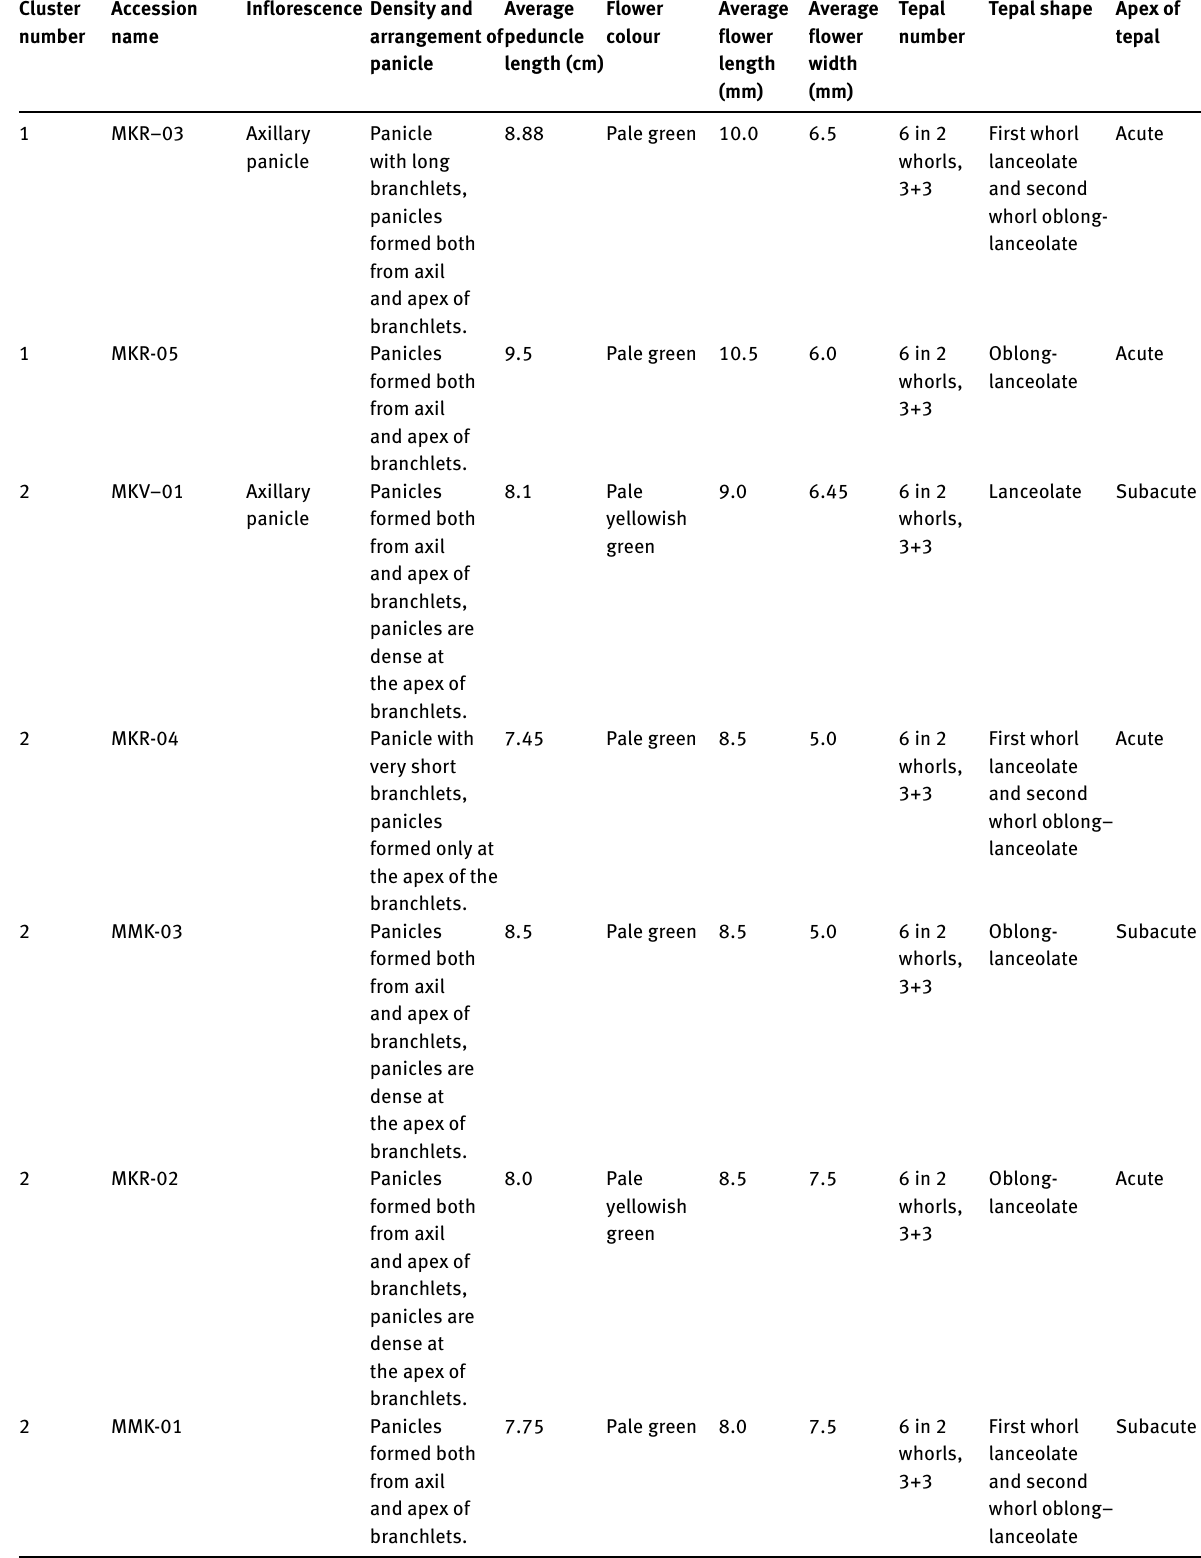
Table 2: Comparative inflorescence and floral morphology of representative cinnamon accessions derives from the four clusters Cluster